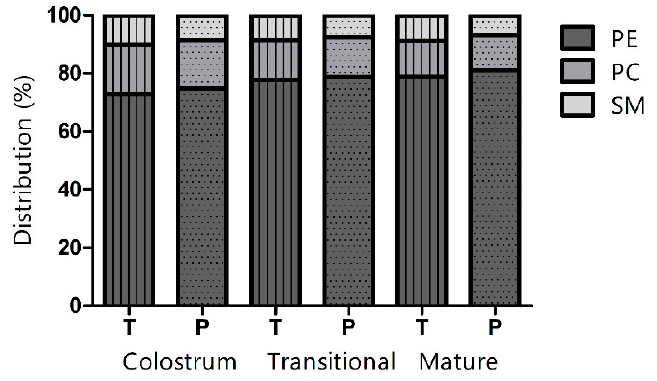
Figure 1. Percentage distribution of phosphatidylethanolamine (PE), phosphatidylcholine (PC) and sphingomyelin (SM) in term (T; vertically striped bars) and preterm (P; dotted bars) colostrum, transitional and mature milk.